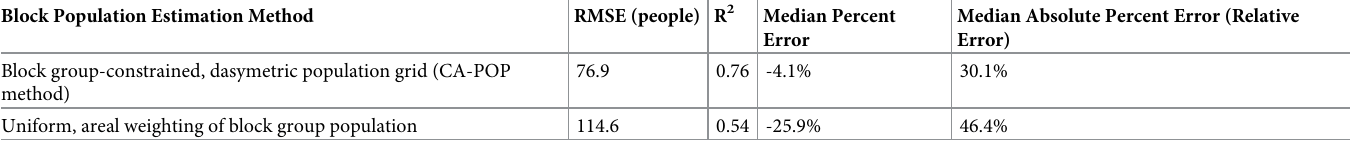
Table 3. Summary error statistics of block group-constrained CA-POP grid.